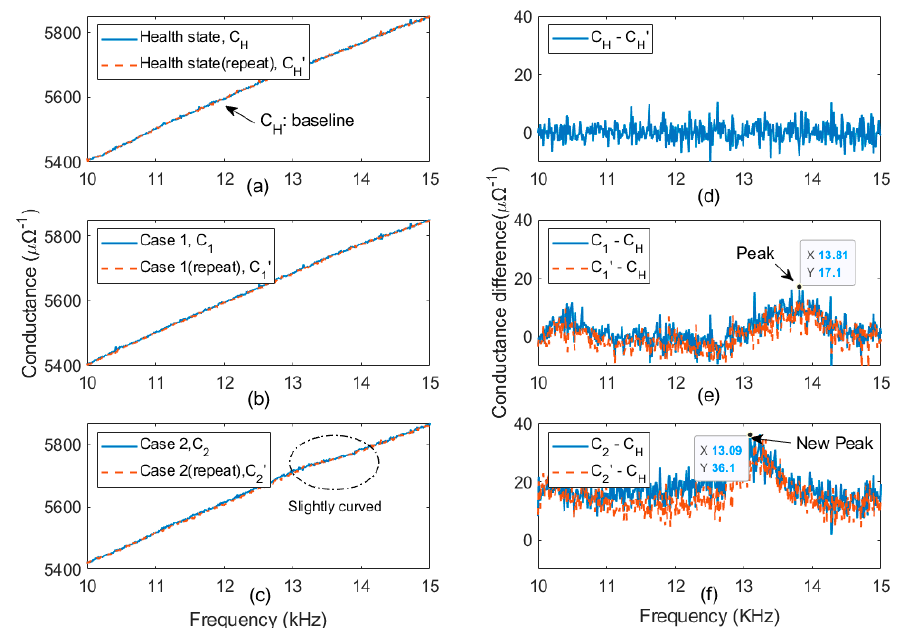
Figure 16. Damage quantification using the electromechanical impedance (EMI) method: ( a ) the conductance in the health case; ( b ) the conductance in damage case 1; ( c ) the conductance in damage case 2; ( d ) the di ff erence between C H and C ; ( e ) the di ff erence in conductance between damage case 1 and the health case; ( f ) the di ff erence in conductance between damage case 2 and the health case.